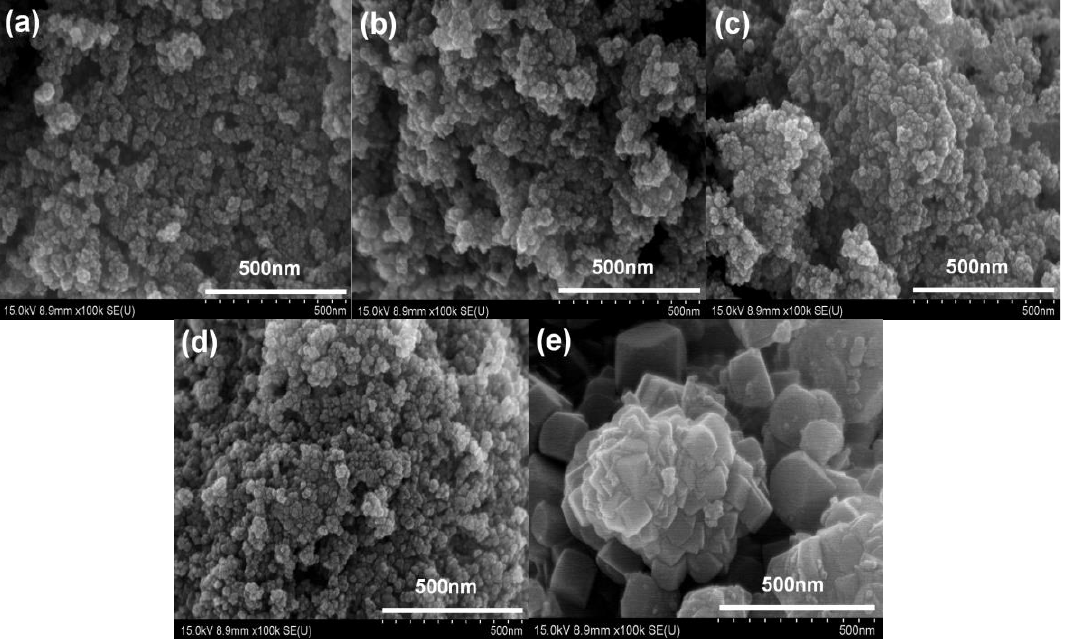
Figure 2. FE-SEM images of ( a ) CFO ( b ) CO-CFO-12.5 ( c ) CO-CFO-25 ( d ) CO-CFO-37.5 and ( e ) CO.